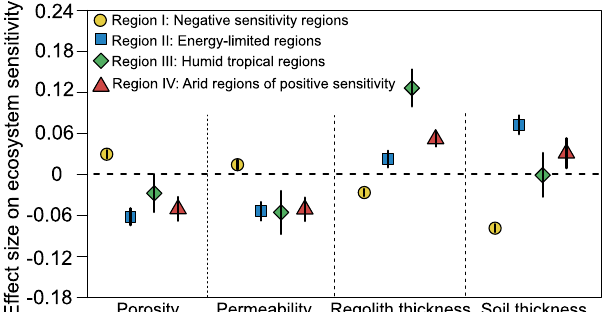
Fig. 4 Effect size of variables describing the properties of bedrock and its products on ecosystem sensitivity for four regions. Effect size of each variable is inferred by the mean (denoted by circles, squares, diamonds, and triangles) and 95% credible interval (denoted by the vertical line) of posterior estimates of regression coef fi cients from the model. De fi nitions of four regions are provided in Fig. 1 and Table